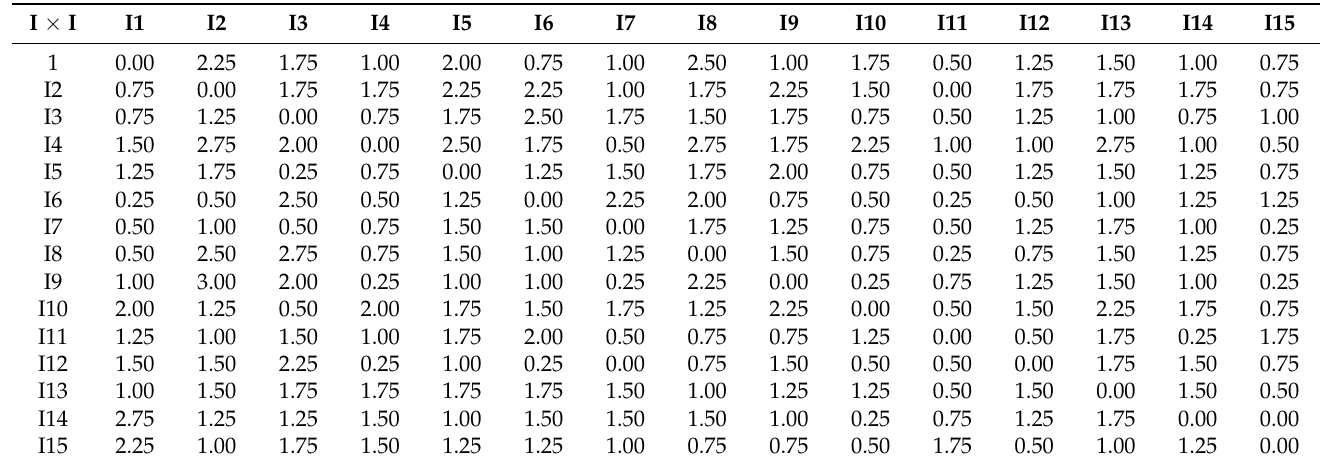
Table A1. I4Es correlation matrix Im.